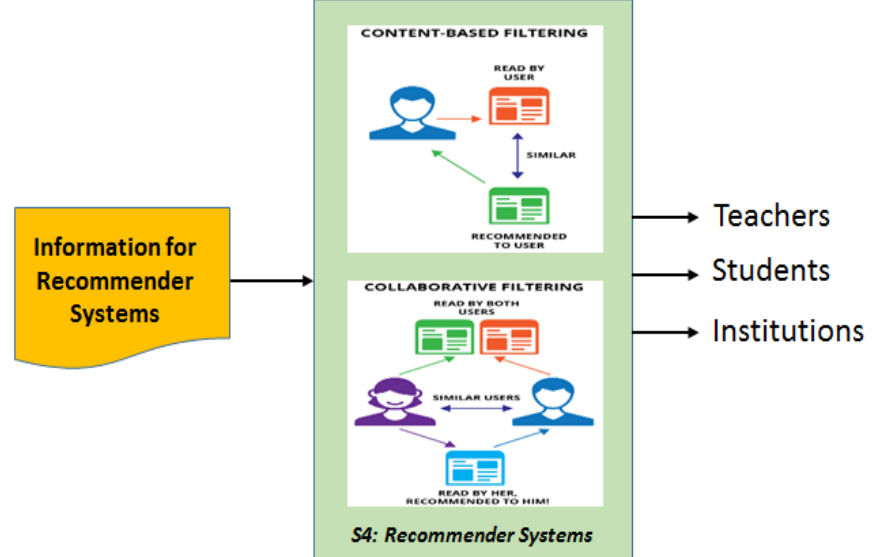
Figure 7. Recommender systems.